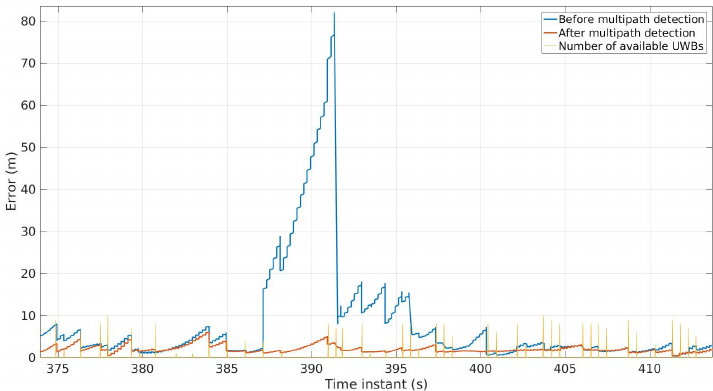
Figure 18. View2: Zoomed view of Figure